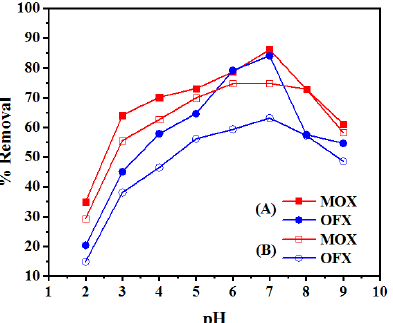
Figure 7. Effect of solution pH on removal rate of MOX and OFX ( A ) by Met-GO/SA (initial concentration: 20 mg/L, dosage: 0.25 g, temperature: 35 °C, time: 140 min) ( B ) by GO/SA (initial concentration: 20 mg/L, dosage: 0.4 g, temperature: 35 °C, time: 200 min).